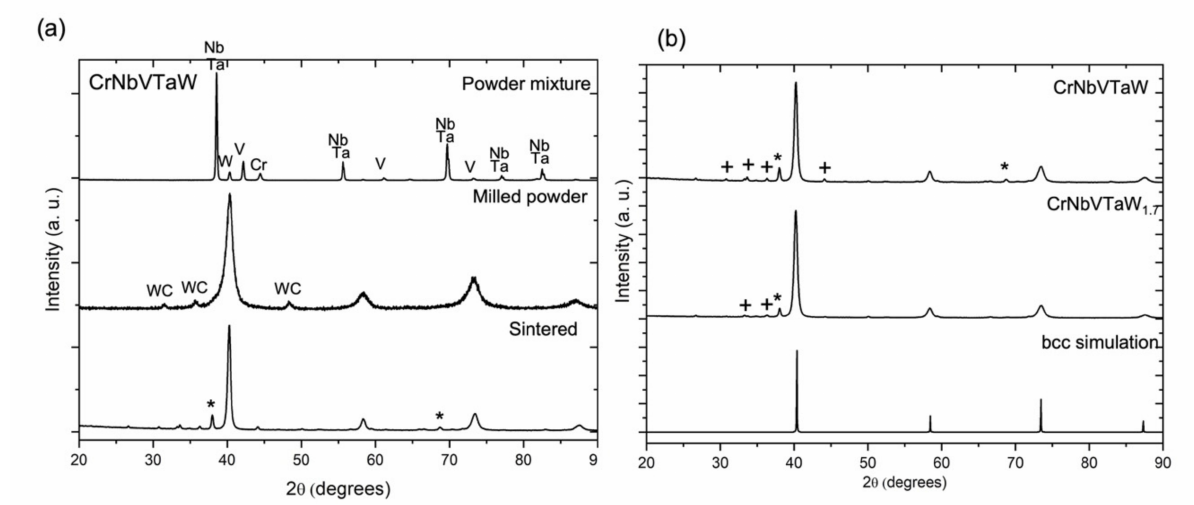
Figure 1. X-ray diffractogram of ( a ) evolution of the phase formation on CrNbTaVW high entropy alloy (powder mixture, milled powder and sintered sample) and ( b ) sintered CrNbTaVW and CrNbTaVW 1.7 together with theoretical simulation of the bcc-type structure with a = 0.316 nm. The symbol * indicates the presence of a bcc-type structure theoretical simulation with a = 0.334 nm. The symbols + indicate minor unidentified structures.